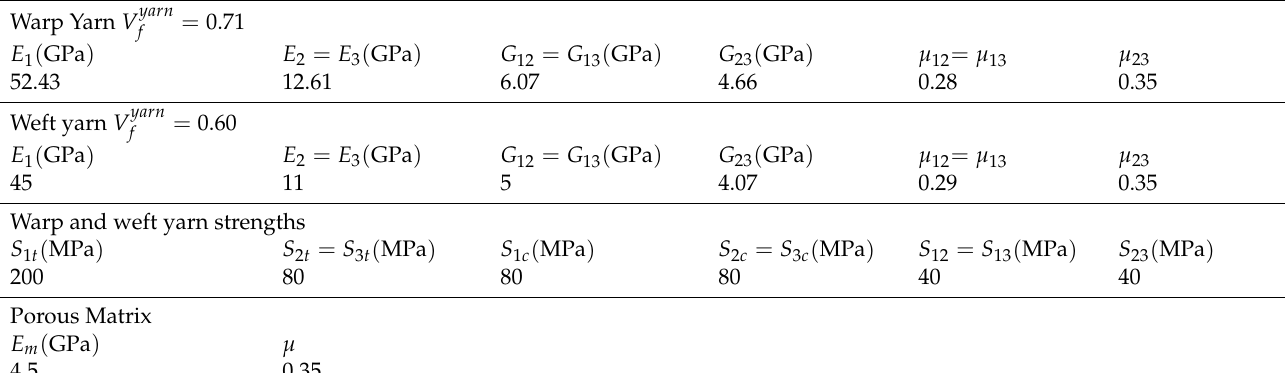
Table 4. The material properties for the homogenized yarns and porous matrix in the FE